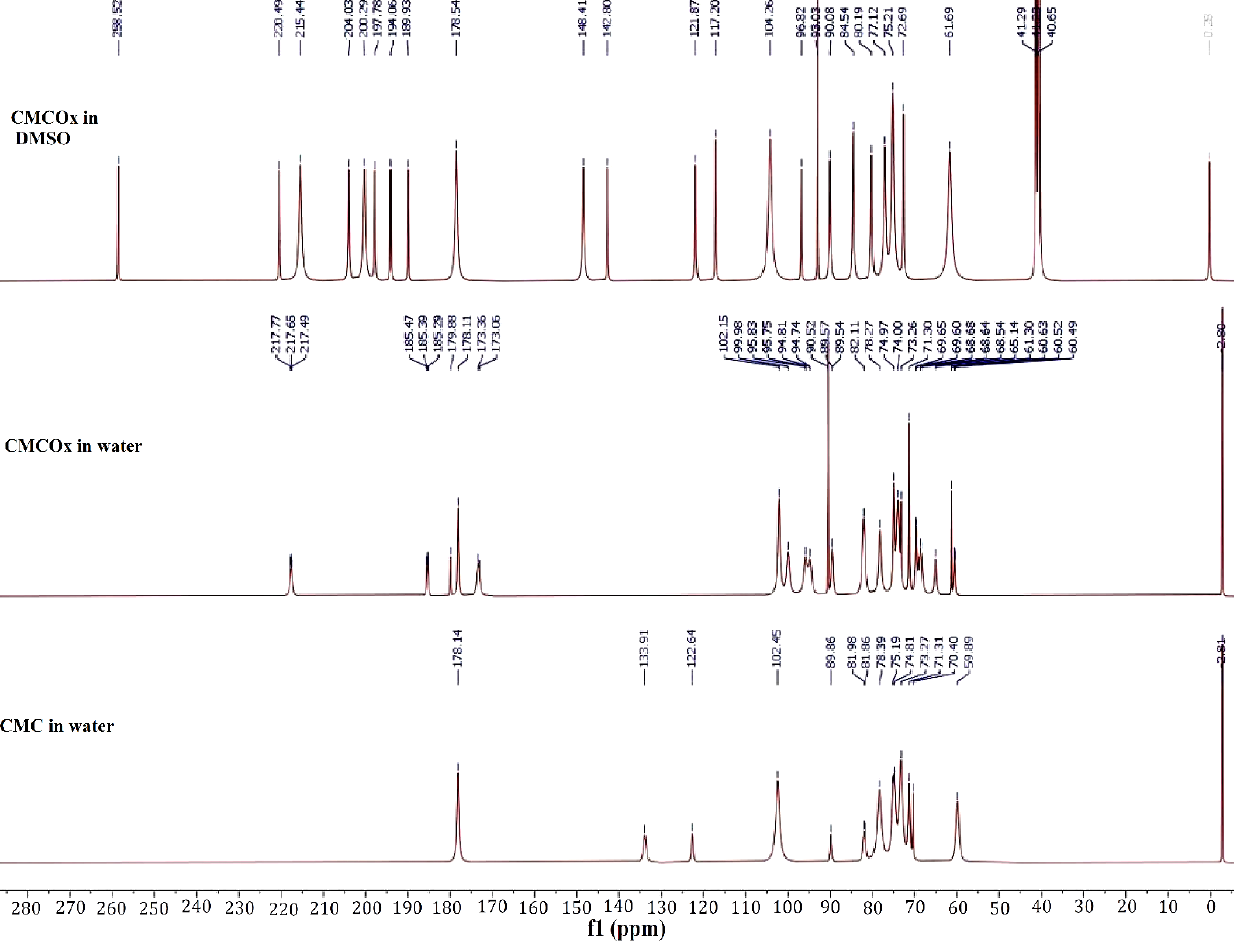
Figure 3. Carbon-13 nuclear magnetic resonance ( 13 C NMR) spectra for CMC dissolved in water, CMCOx dissolved in water, and CMCOx dissolved in DMSO.